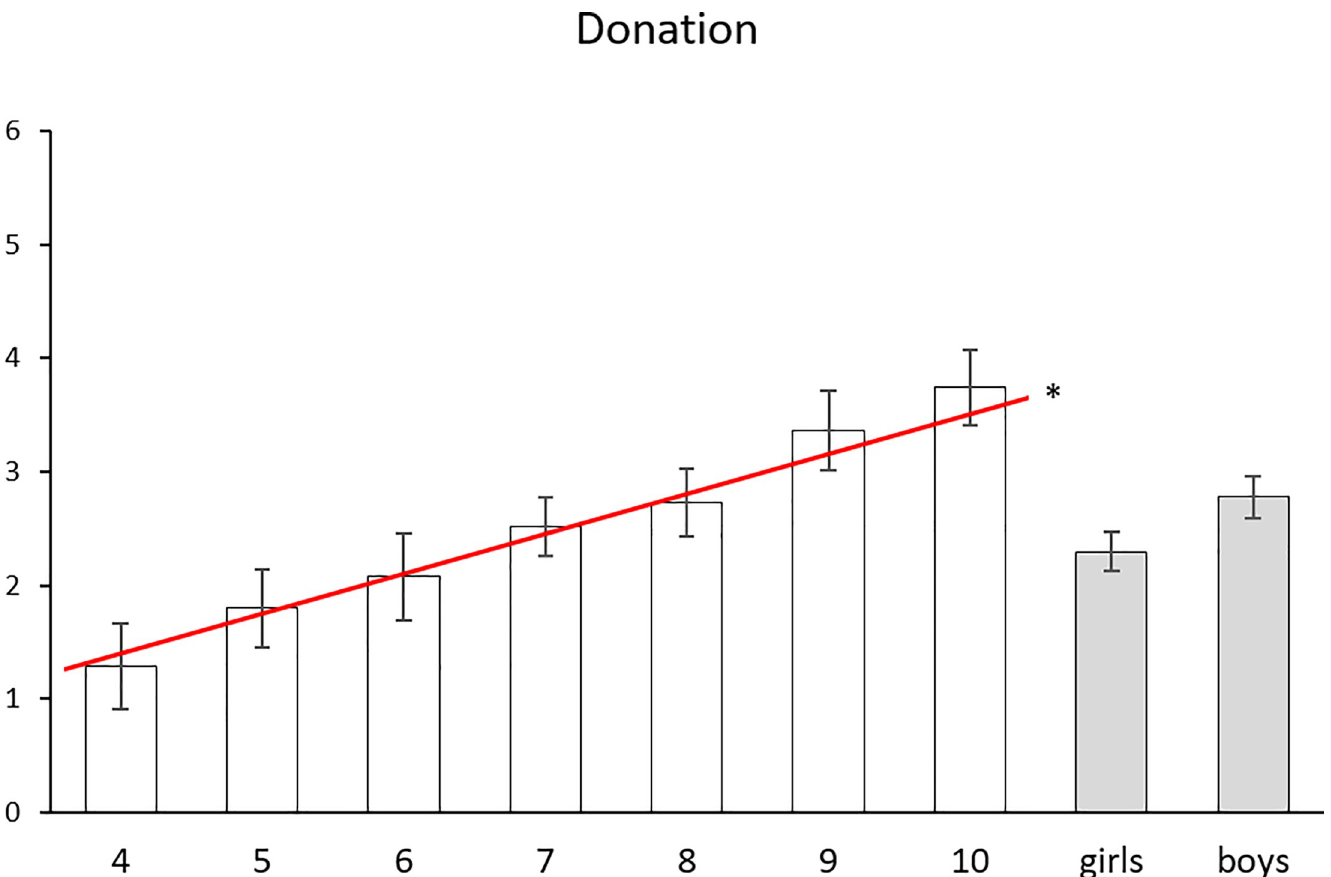
Fig 5. Children’s donation scores (out of 6) as a function of age and gender. The red line indicates the significant positive linear effect of age. There was no significant effect of gender.